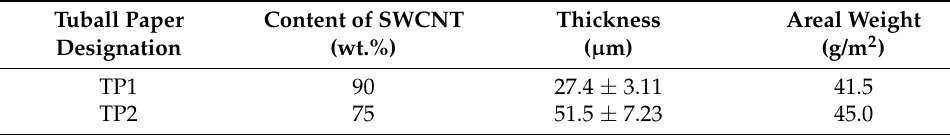
Table 1. Characteristics of Tuball papers used.